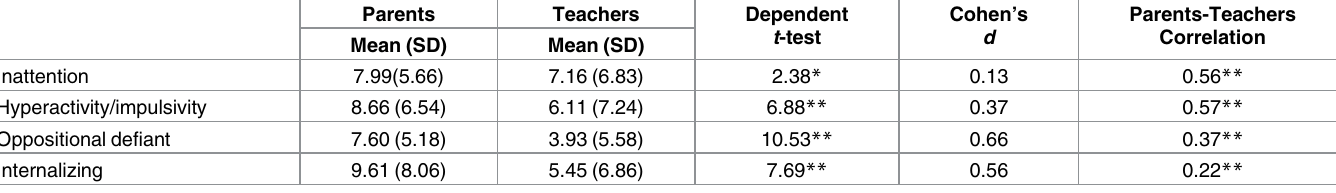
Table 2. Parent and teacherrating